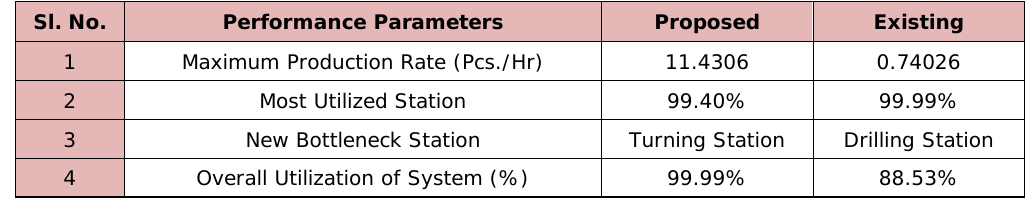
Table 8. “Comparison Chart of Performance Parameters of FMS (Proposed vs. Existing)”. Source: Own contribution.